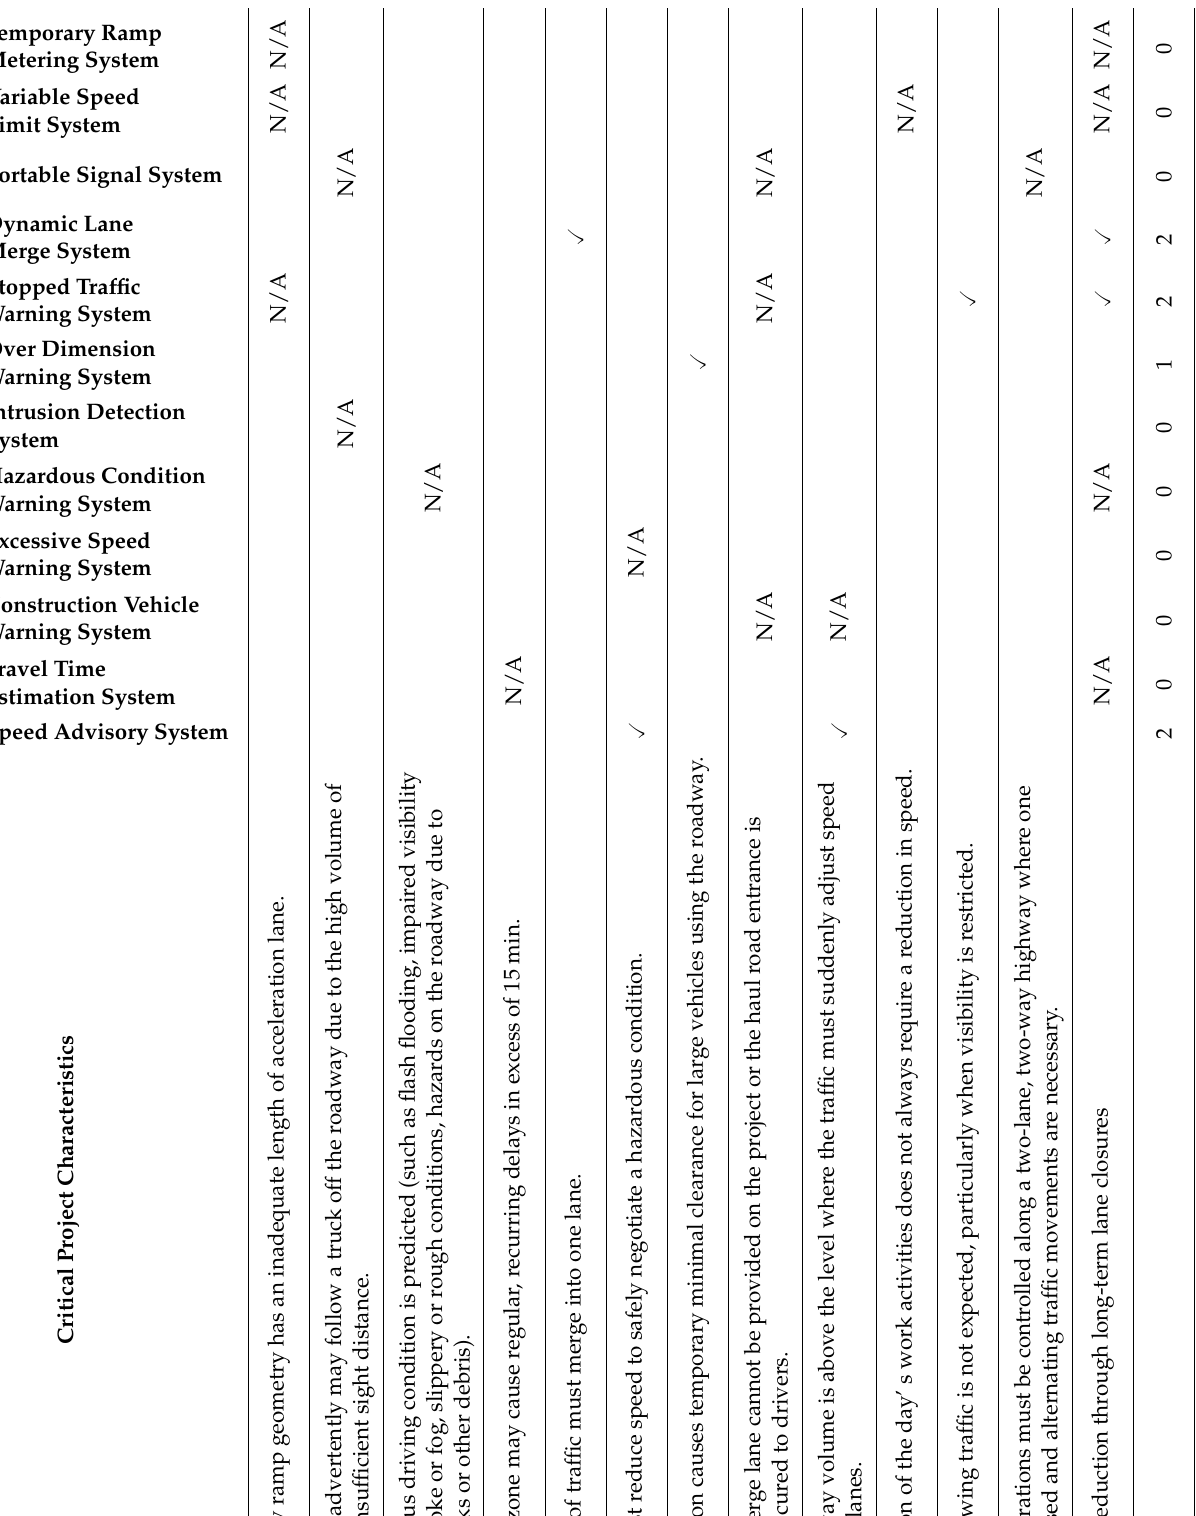
Table 9. Critical project characteristics for the case